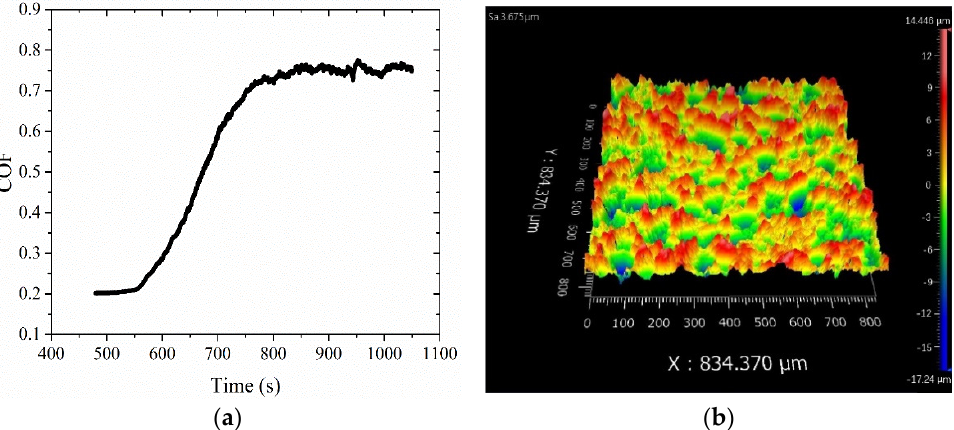
Figure 4. ( a ) Evolution of COF between the copper specimen and the steel ball and ( b ) surface morphology of the copper specimen.